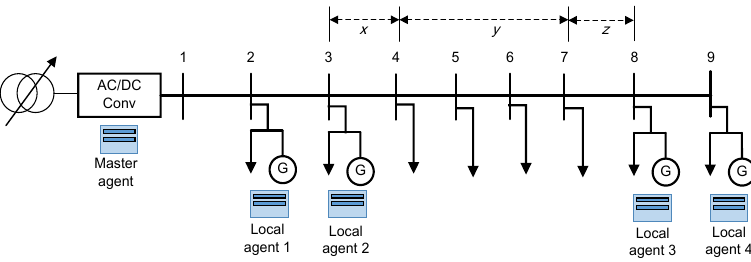
Figure 10. Configuration of a LVDC distribution system and MAS-based control system for simulation studies. Table 1. Line parameters of the test LVDC distribution system shown in Figure 10.